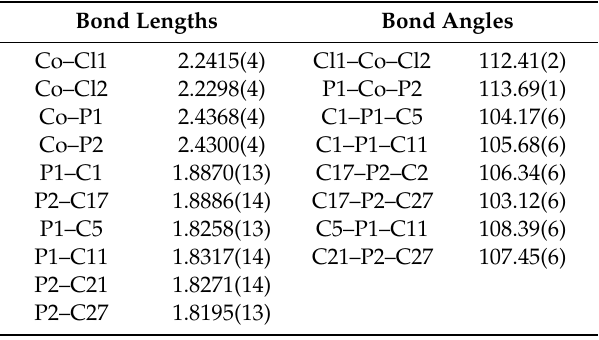
Table 1. Selected bond lengths (Å) and angles ( ◦ ) for CoCl 2 (P t BuPh 2 ) 2 ( 1 ). Bond Lengths Bond